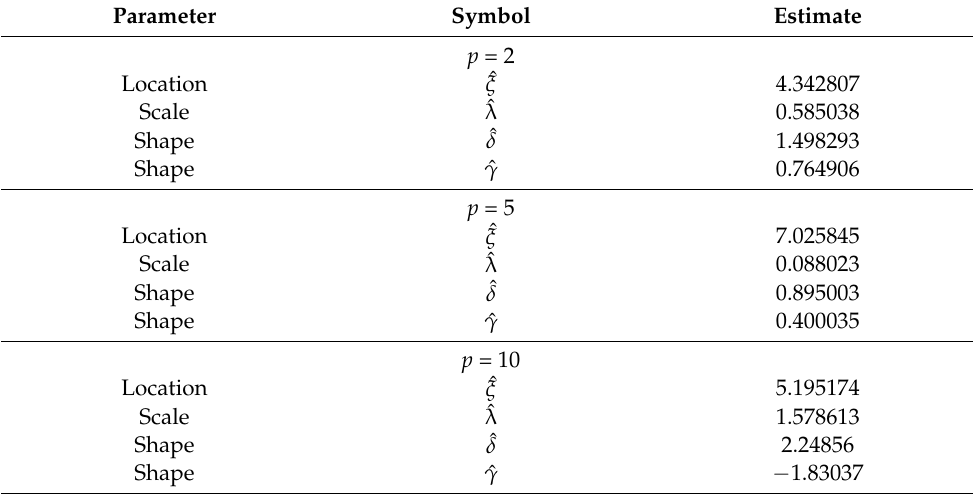
Table 1. Statistic T ∗ Johnson S U distribution parameter